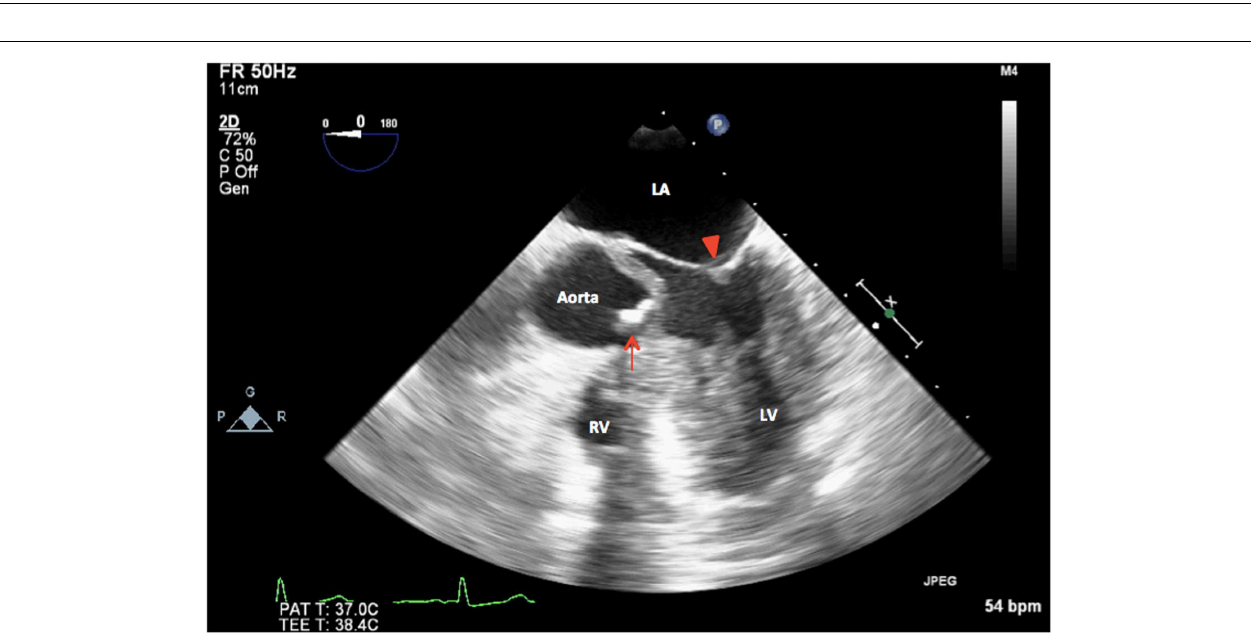
FIGURE 4 | 2DTEE midesophageal modified five-chamber view showing severely calcified and restricted unicuspid aortic valve in systole (arrow). LA, left atrium; LV, left ventricle, mitral valve (arrowhead); RV, right ventricle.